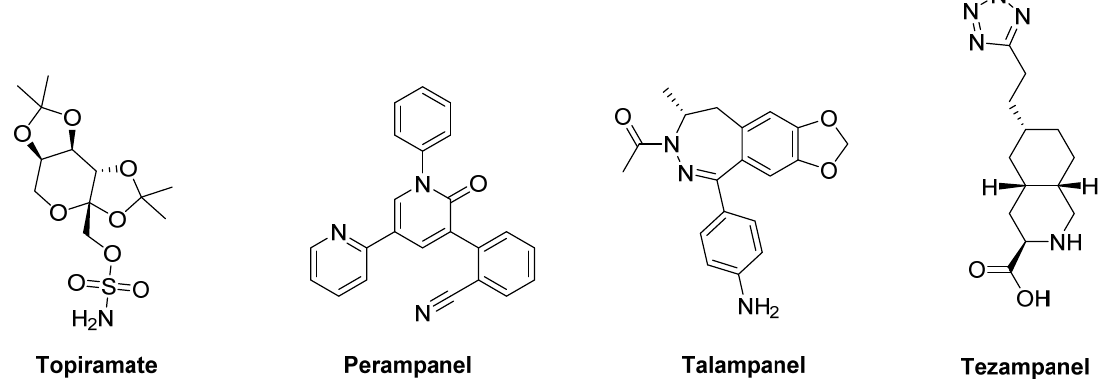
Figure 6. amino ‐ 3 ‐ hydroxy ‐ 5 ‐ methyl ‐ 4 ‐ isoxazolepropionic acid (AMPA) receptor ligands. Figure 6. amino-3-hydroxy-5-methyl-4-isoxazolepropionic acid (AMPA) receptor